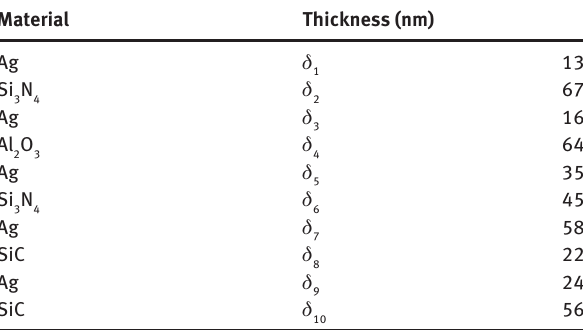
Table 2: Five-pair design optimization.